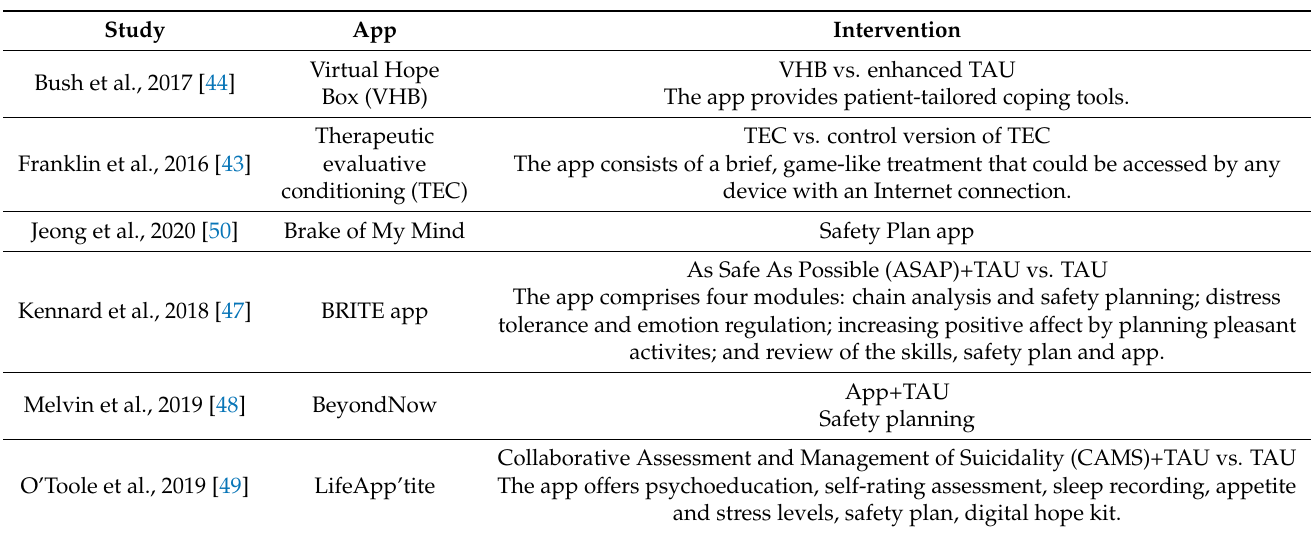
Table 3. Intervention proposed by the studies on the efficacy of mobile